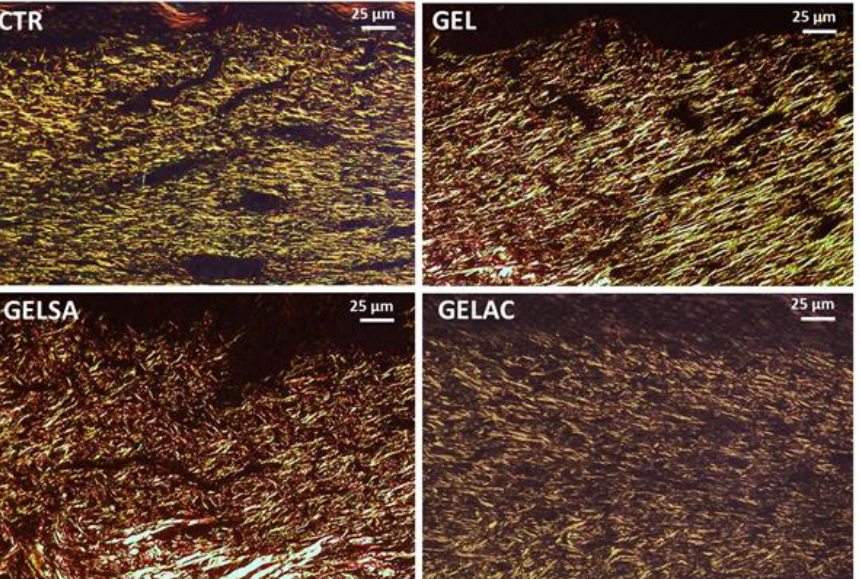
Figure 17. Photomicrographs of histological sections stained in picrosirius and analyzed under polarized light representative of the 14-day repair process. All groups present thicker collagen fibers of variable length with golden and reddish birefringence, consistent with type I collagen, arranged in a pattern predominantly parallel to the wound surface; the interfibrillar spaces (dark) were very reduced (400 × ). Caption: CTR—control group; GEL—group treated only with gelatin biomembranes; GELSA—group treated with gelatin biomembranes containing S. adstringens extract; GELAC—group treated with A. cochliacarpa extract.